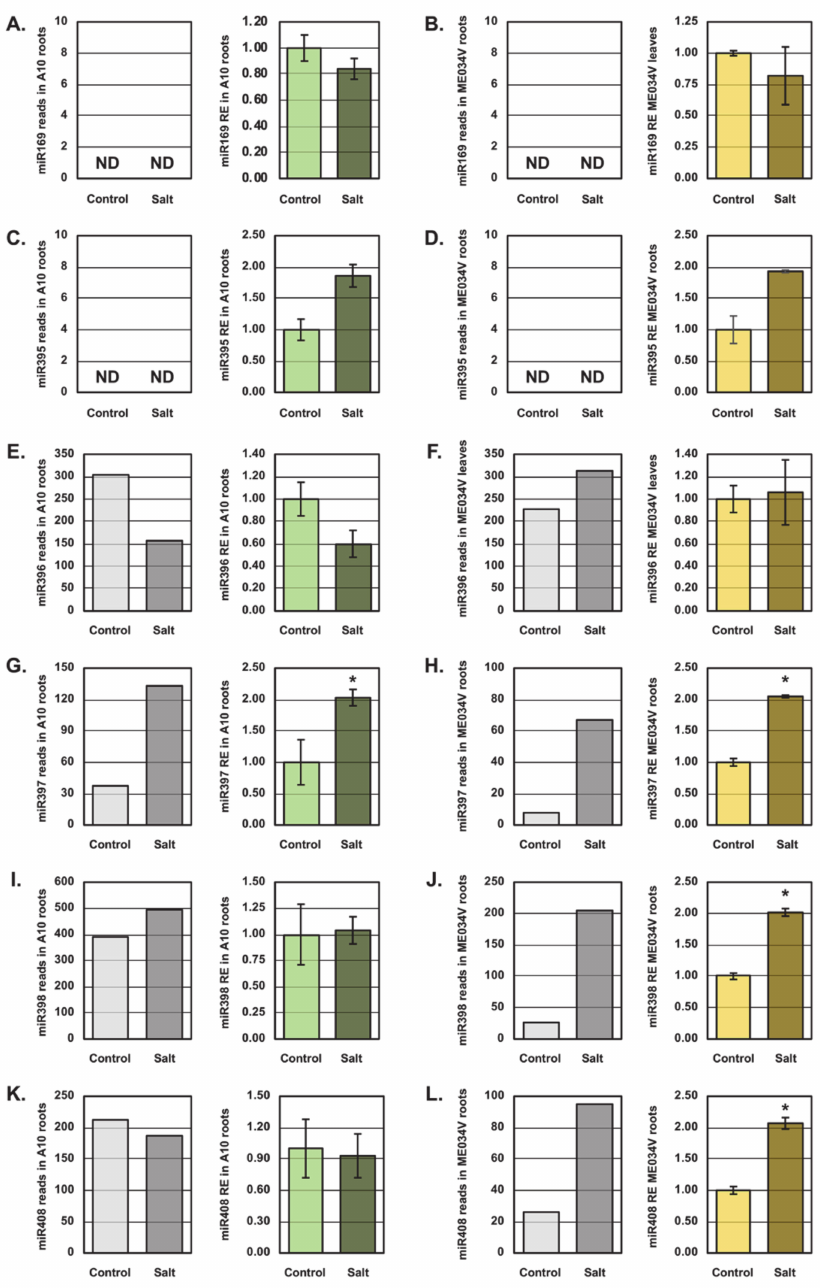
Figure 4. Experimental validation of the response of six miRNAs to salt stress in Setaria viridis roots. RT-qPCR quantification of miRNA abundance to experimentally validate the sRNA sequencing identified abundance trends documented for the root tissue of 10-day-old salt stressed A10 and ME034V seedlings, including miR169 in salt stressed A10 ( A ) and ME034V ( B ) roots, miR395 levels in A10 ( C ) and ME034V ( D ) salt stressed roots, miR396 abundance in salt stressed A10 ( E ) and ME034V ( F ) root tissues, miR397 levels in salt stressed A10 ( G ) and ME034V ( H ) root tissue, miR398 abundance in salt stressed A10 ( I ) and ME034V ( J ) roots, and the levels of the miR408 sRNA in salt stressed A10 ( K ) and ME034V ( L ) root tissue samples. The bars on the histograms represent the standard deviation of the four biological replicates analyzed by RT-qPCR. Statistical di ff erence was determined with a t -test and the asterisk represents a p -value of * p <